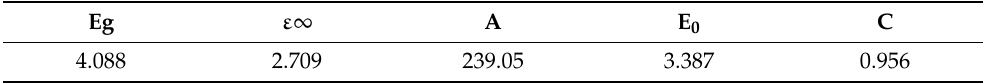
Figure 3. Complex refractive index of PECVD-deposited silicon nitride as obtained from the fit of ellipsometric data.